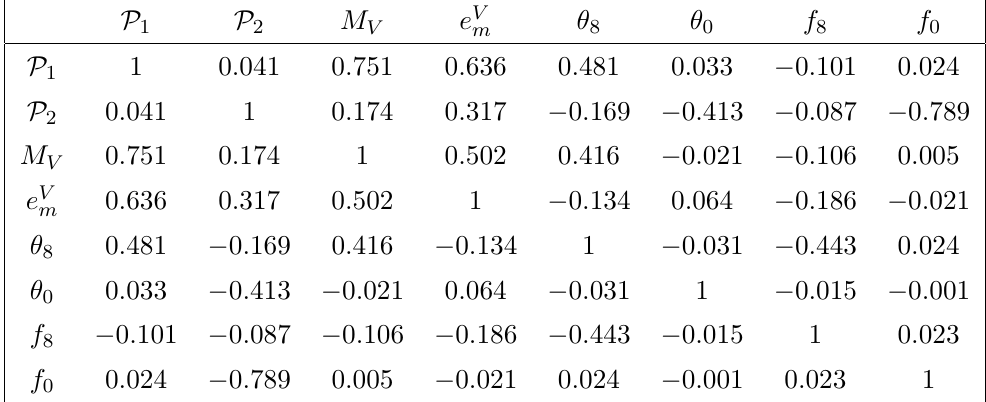
Table 14 . Correlation of (cid:12)tted parameters including the (cid:25) 0 form-factor BaBar data, ‘(cid:12)t 1’.